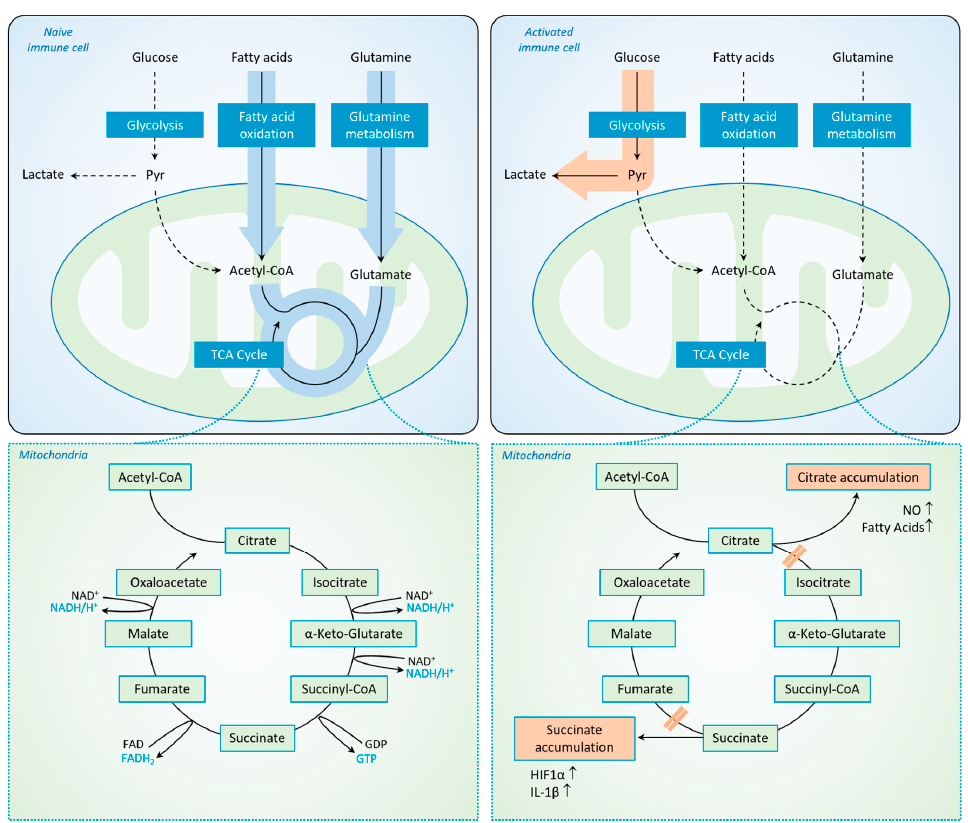
Figure 1. The “Warburg effect” in activated immune cells. Visualization of the interaction of glycolysis and the tricarboxylic acid cycle (TCA) pathway in naive ( left side ) and activated ( right side ) immune cells. While energy production relies on the TCA in native immune cells (solid arrows highlighted in blue) and Glycolysis is of minor importance (dashed arrows left side ), the TCA is blocked on two breaking points in activated immune cells, which results in citrate and succinate accumulation. As a result, energy production in activated immune cells relies on Glycolysis (solid arrows highlighted in orange) while the TCA is of minor importance (dashed arrows). Upward arrows symbolize increased levels. Abbreviations: Pyr = Pyruvate, NADH = Nicotinamide adenine dinucleotide (NAD + in its oxidated form), GDP/GTP = Guanosine diphosphate/Guanosine triphosphate, HIF1 α = Hypoxia- inducible factor 1- α , IL-1 β = Interleukin 1 β , NO = nitric oxide.